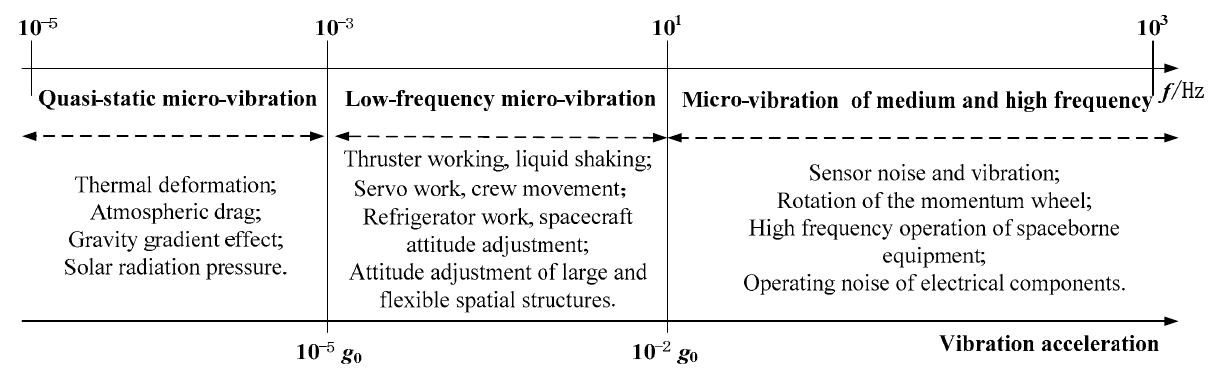
Figure 1. Frequency distribution of micro–vibration sources.